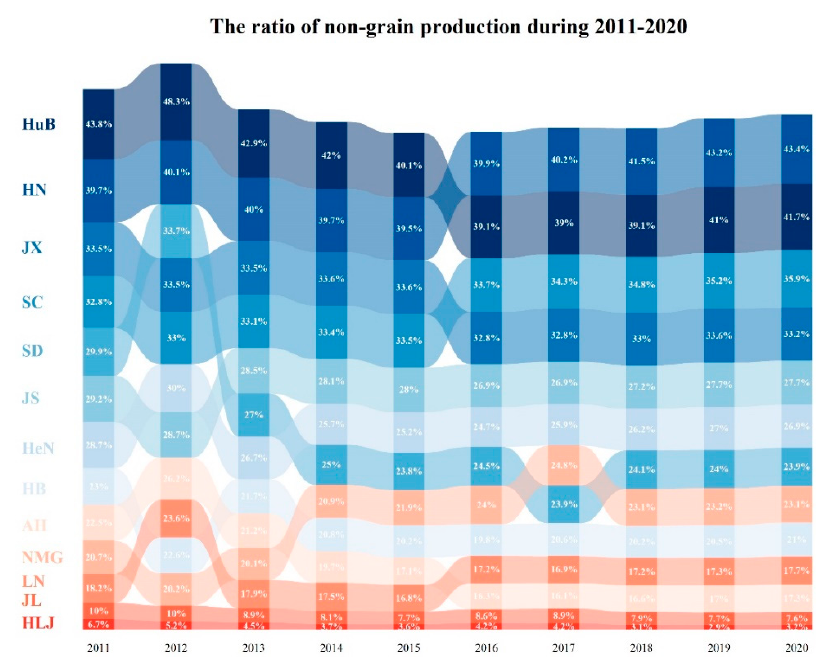
Figure 3. The ratio of non-grain production during 2011–2020. The non-grain production ratios in the southern provinces of Hubei, Hunan, Jiangxi, and Sichuan were always above 30%; the average non-grain production ratios in Hubei Province and Hunan Province were higher than 40%; and the average ratios of non-grain production in Jiangsu, Henan, Shandong, Inner Mongolia Autonomous Communities, Hebei, Anhui, and Liaoning provinces were 27.89%, 26.71%, 25.98%, 22.19%, 21.03%, 19.00%, and 18.03%, respectively. From 2011 to 2020, Heilongjiang and Jilin provinces ranked as the last two in terms of non-grain productivity: Heilongjiang’s average non-grain productivity was at 4.11%, with the highest non-grain production ratio at 6.68% in 2011 and the lowest non-grain productivity at 2.92% in 2019, showing a decreasing trend. Jilin’s average non-grain productivity was at 8.55%, with the highest non-grain productivity at 10.02% and the lowest non-grain productivity at 7.63 in 2020, showing a decreasing trend. Hubei Province and Hunan Province ranked alternately first and second in 2015 for non-grain production ratio; Jiangxi Province and Sichuan Province ranked alternately third and fourth in 2015 for non-grain production ratio except for 2012; Jiangsu Province, Henan Province, Inner Mongolia, and Liaoning Province ranked in a fluctuating upward trend for non-grain production ratio; and Shandong Province, Hebei Province, and Anhui Province ranked in a fluctuating downward trend for non-grain production ratio. It could be observed that there was no significant relationship between the proportion of grain production to total national production and the ratio of non-grain production in the thirteen major grain-producing provinces during 2011–2020 (Figures 2 and 3). For example, Heilongjiang had a high proportion of total national grain production and a low ratio of non-grain production; Henan and Shandong Province had a high proportion of total national grain production and a high ratio non-grain production; Jiangxi Province had a low proportion of total national grain production and a low ratio non-grain production; Hubei, Hunan, and Sichuan Provinces had a low proportion of total national grain production and a high ratio non-grain